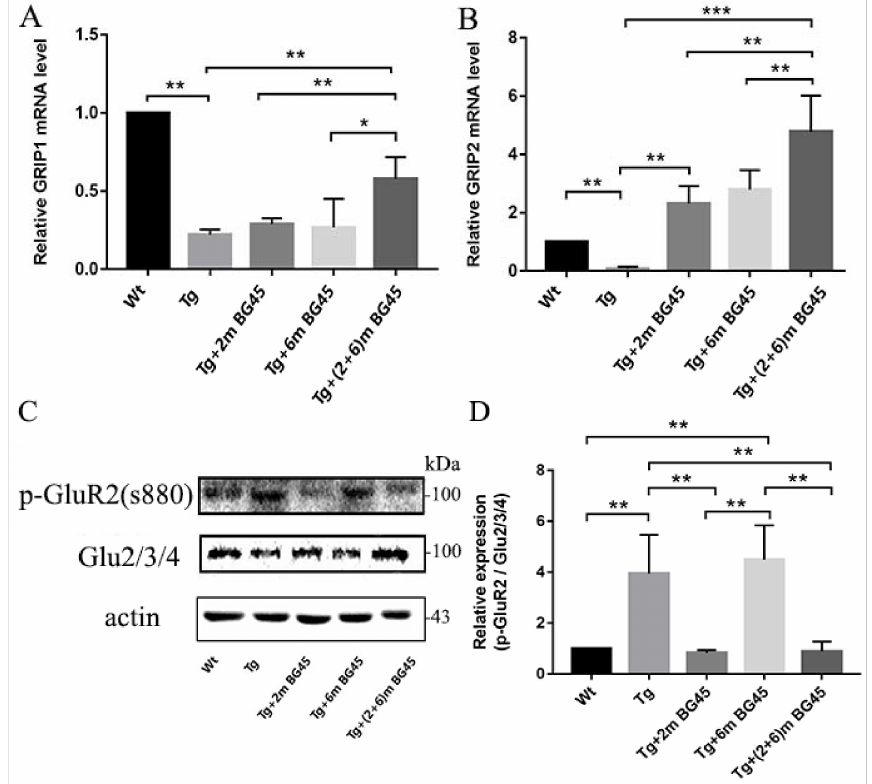
Figure 12. Effects of BG45 on the expression levels of glutamate receptor proteins and related genes. ( A , B ). GRIP1 and GRIP2 mRNA expression levels. ( C ) Immunoblot analysis of p-GluR2 (s880) and Glu2/3/4 levels in the hippocampus of mice treated with vehicle or BG45. ( D ) Quantification of p-GluR2 levels in the hippocampus. Significant differences were determined using one-way ANOVA. All values are presented as the means ± SD from three independent experiments. * p < 0.05, ** p < 0.01, and *** p < 0.001, n = 5 mice per